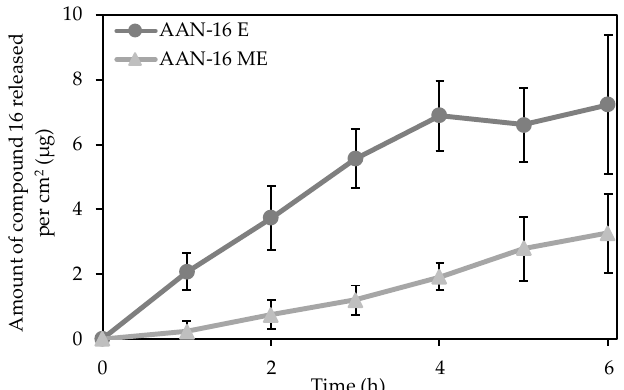
Figure 5. Drug release studies of AAN-16 E and AAN-16 ME using a synthetic membrane (Tuffryn ® ). Results expressed as average ± SD, n = 6.